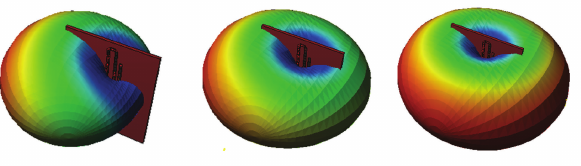
Figure 12: Three indicative radiation patterns obtained from